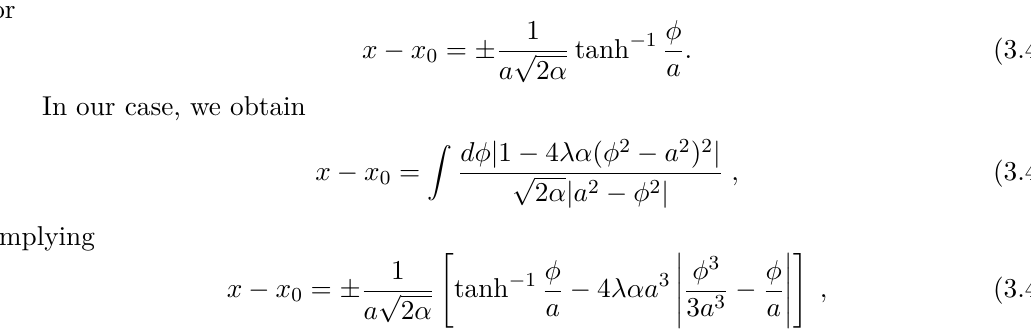
Figure 5 . The profile of the modified Sine-Gordon soliton. µ λµ 2 =0.1, 1, 2 in blue, purple and brown, β